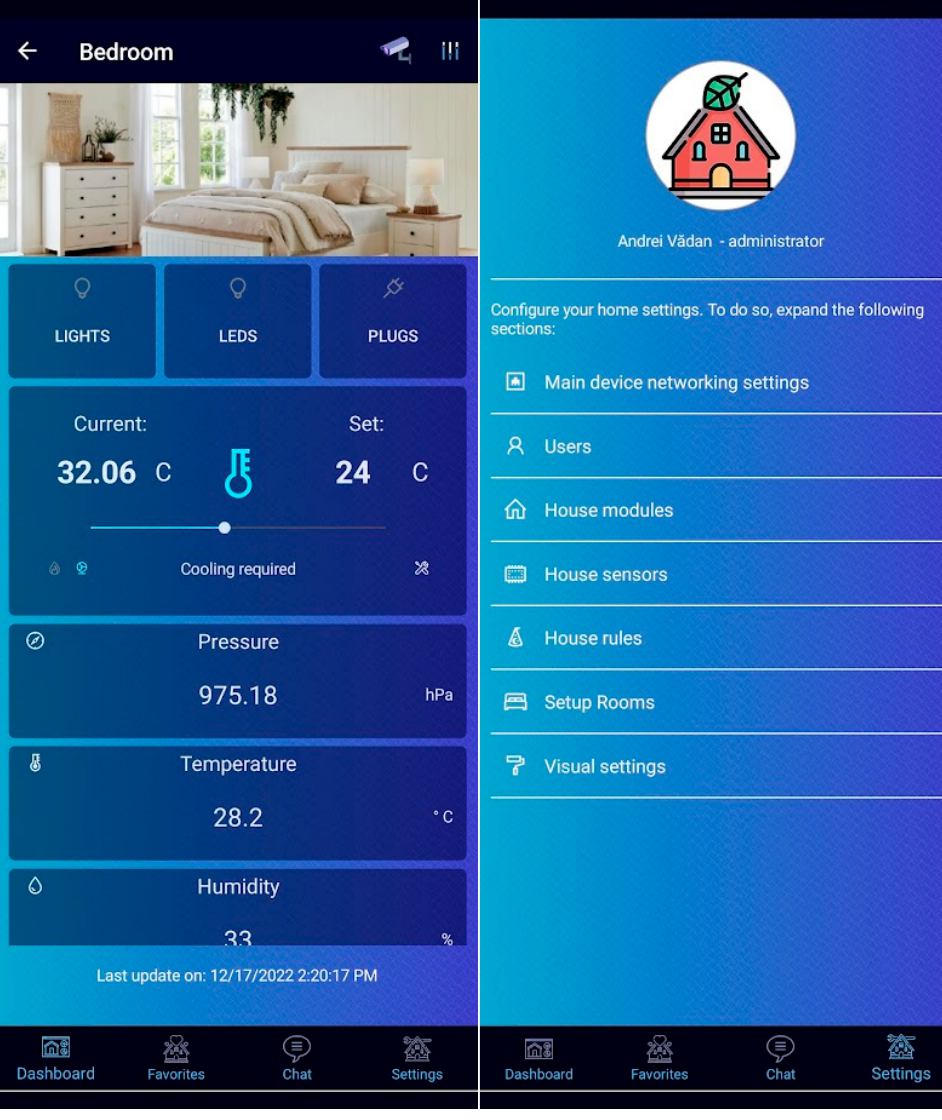
Figure 8. Android application room and settings screens.